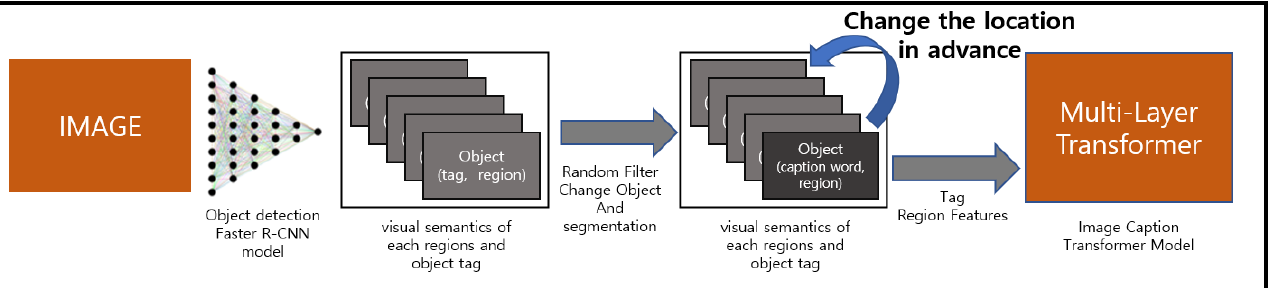
Figure 1. Image Caption It is an inference structure The Domain object dictionary re-aligns the location of the object to induce captions. for image captioning inference.